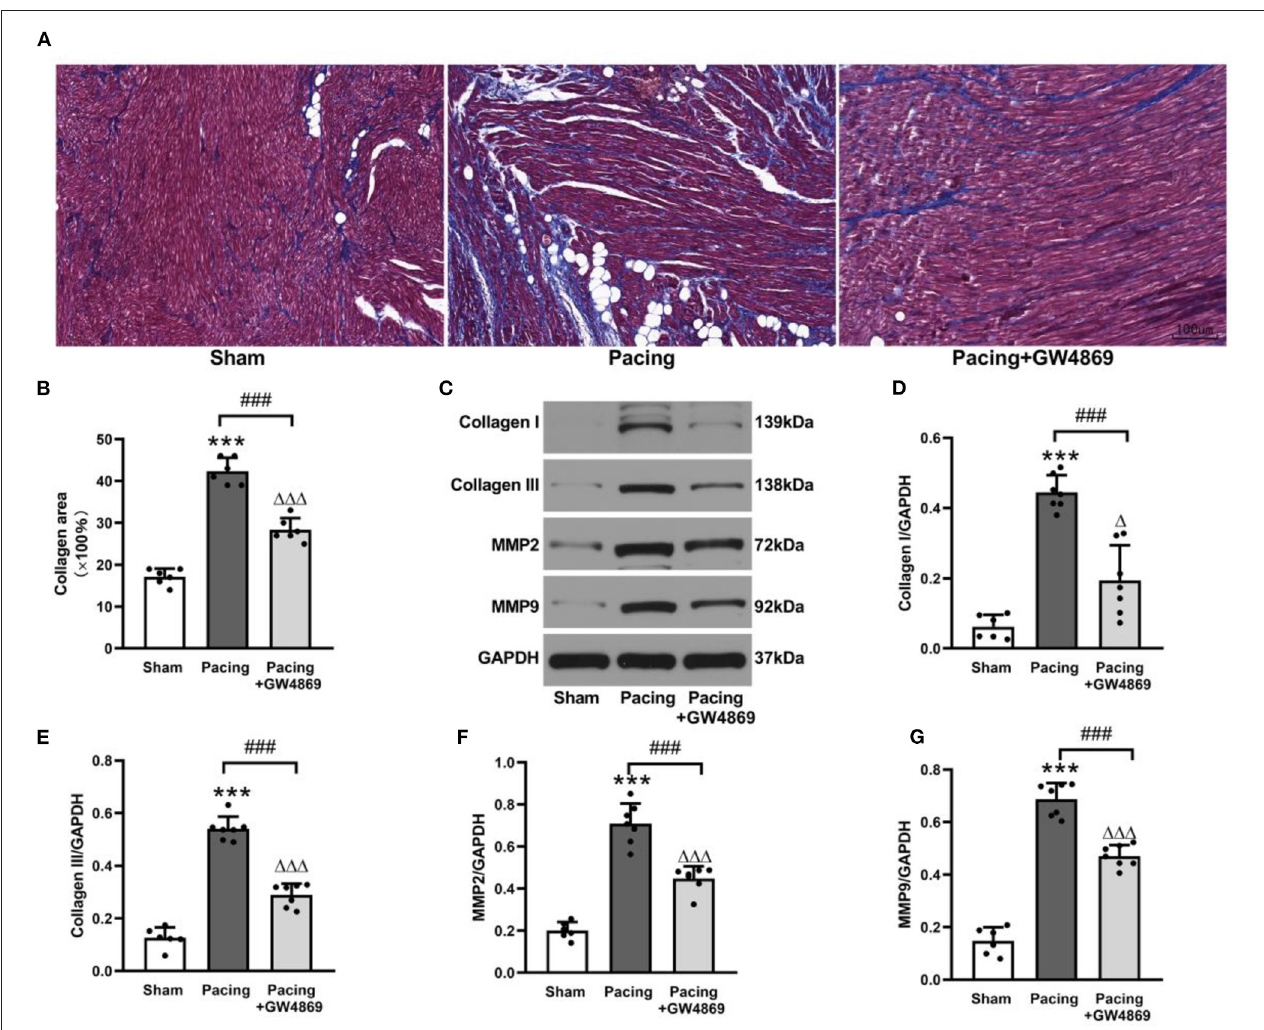
FIGURE 5 | Structural remodeling in a canine model of AF. (A,B) Masson’s trichrome staining of the atria and mean values of collagen area in the atria ( n = 6, × 200). (C–G) Representative Western blotting images and the mean expression levels of collagen I, collagen III, MMP-2, and MMP-9 in the atria ( n = 6 for the sham group and n = 7 for the pacing and GW4869 groups). *** P < 0.001 vs. the sham group. ### P < 0.001 vs. the pacing group. 1 P < 0.05, 111 P < 0.001 vs. the sham group. MMP-2, matrix metalloproteinase-2; MMP-9, matrix metalloproteinase-9; AF, atrial fibrillation.